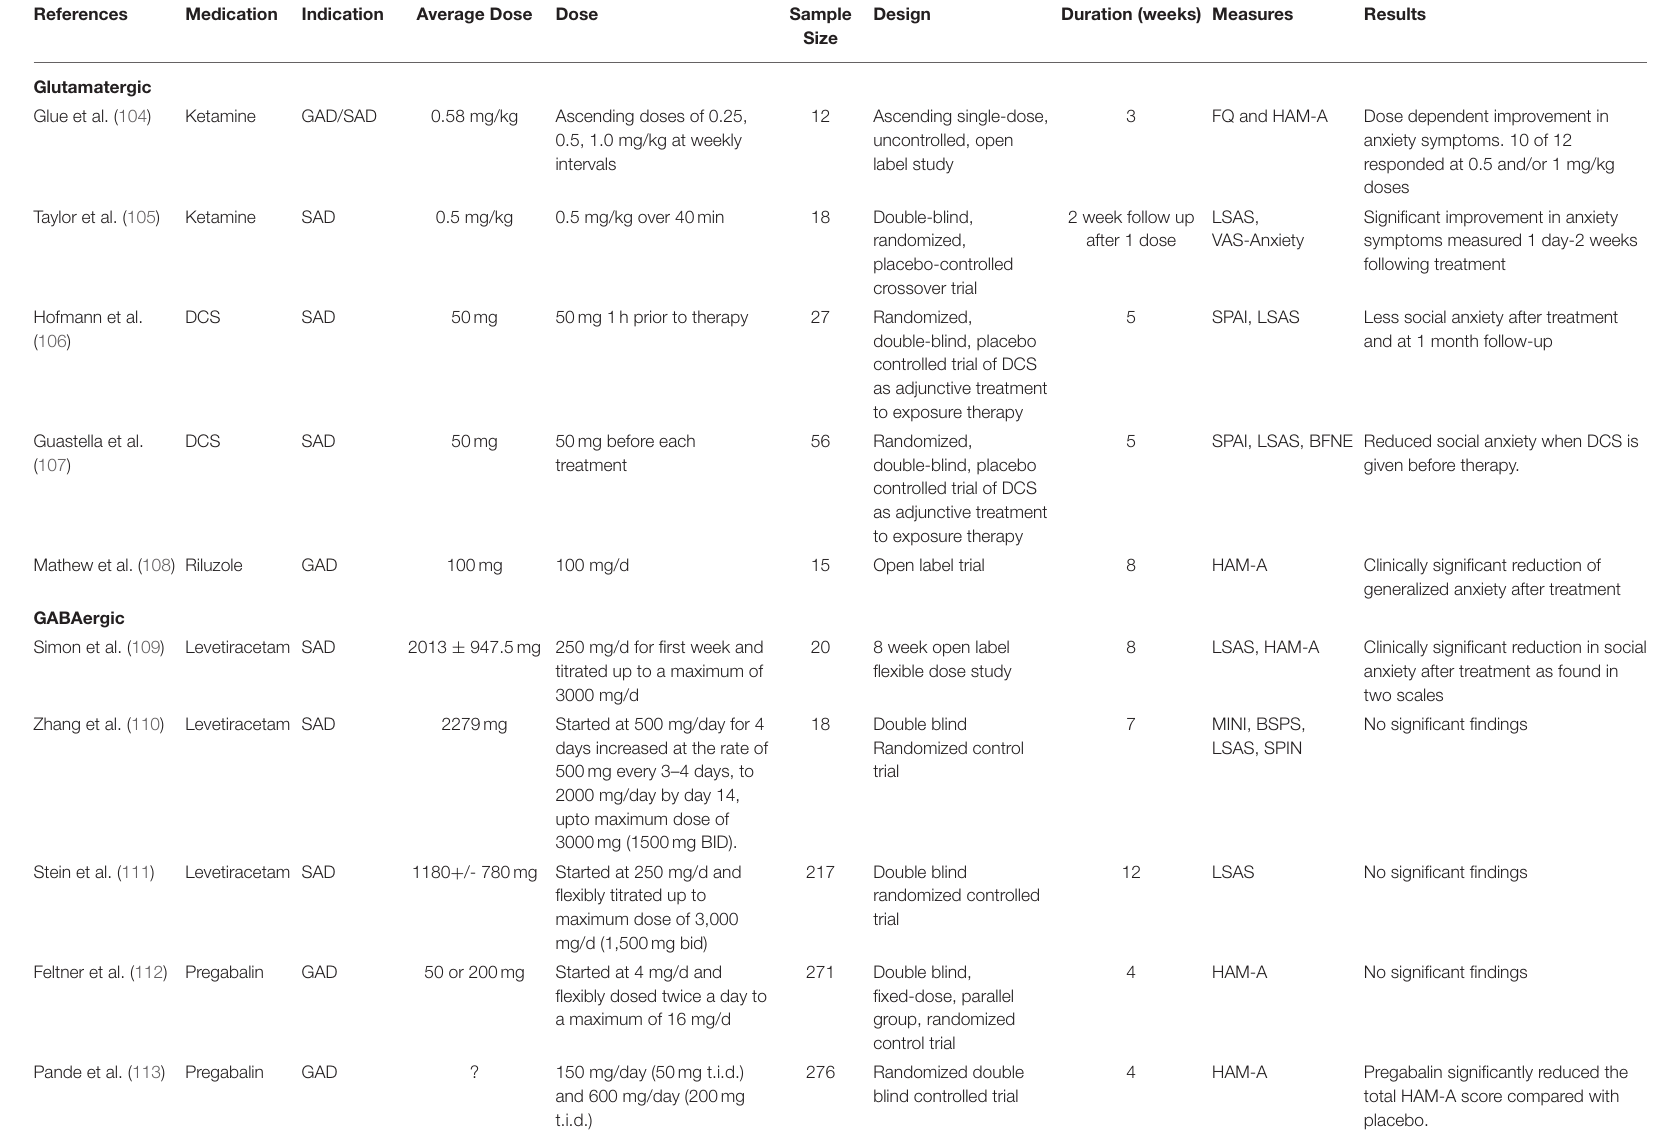
TABLE 3 | Summary of glutamate psychopharmacology trials for anxiety